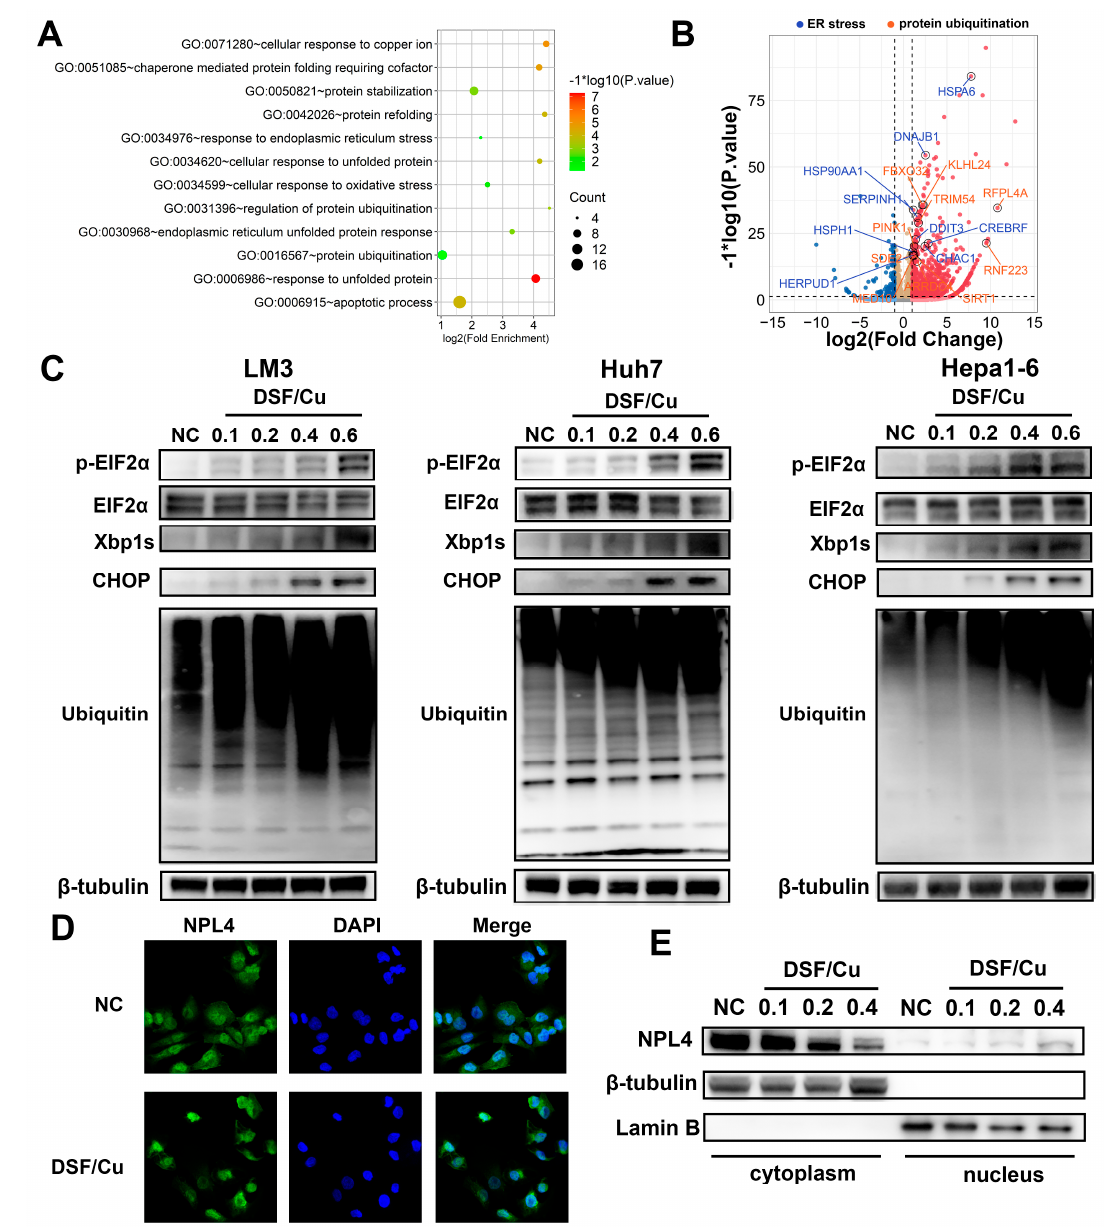
Figure 3. DSF/Cu induces unfolded protein response and inhibits protein degradation. ( A ) Pathway analysis between normal control and DSF/Cu-treated HCC cells. ( B ) Differential expression of unfolded protein response- and protein ubiquitination-related genes between normal control and DSF/Cu-treated HCC cells. ( C ) Western blot analysis of ER stress and poly-ubiquitylated proteins in LM3, Huh7, and Hepa1–6 cells after the treatment of DSF/Cu. ( D ) Fluorescence imaging of NPL4, cell nuclei were stained by DAPI. Images with magnification at 800× are shown here. ( E ) Western blot analysis of cytoplasmic and nuclear NPL4 in DSF/Cu-treated LM3 cells. The uncropped blots are shown in Figure S6.